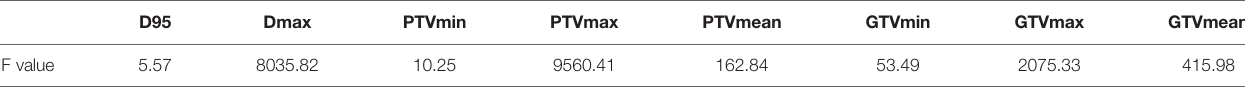
TABLE 2 | VIF values of dosimetric